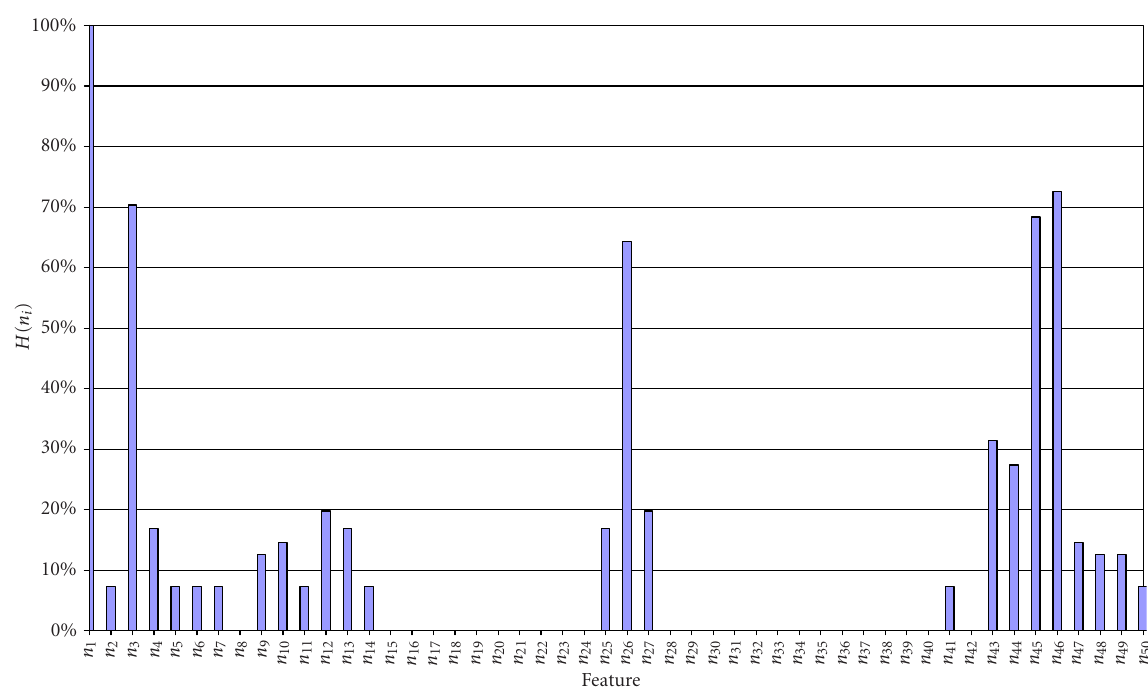
Figure 4: Feature entropy of initial test relative to H ( n 1 ) = 1 . 93 with the semantic being